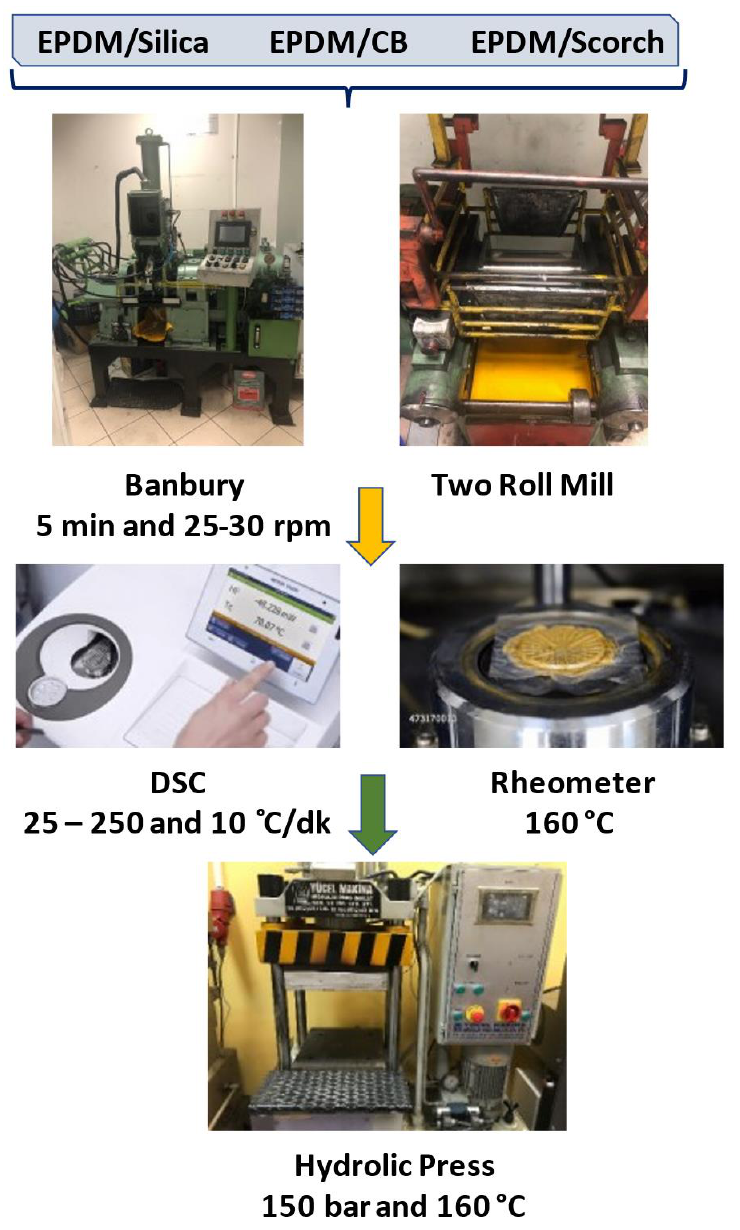
Figure 1. Flow chart of the Banbury compounding.